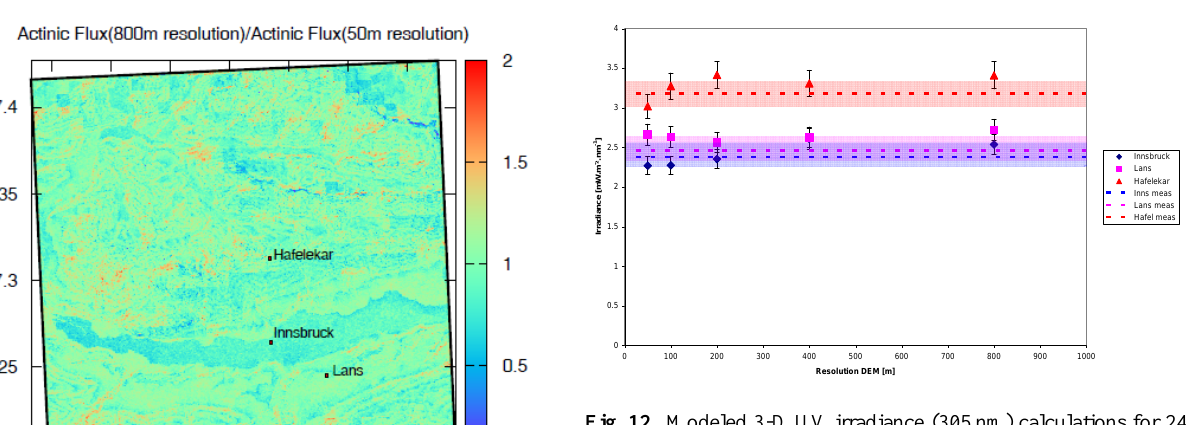
Figure 12: Modeled 3-D UV irradiance (305 nm) calculations for 24 th February, 08:20 UTC as a function of DEM resolution. Dotted lines show the measurements (interpolation of measurements before and after 08:20 UTC) which correspond to the locations and the time of calculation. Solar zenith angle is 70.0 degree. The shapes show the model results (diamond = Innsbruck, square = Lans, triangle = Hafelekar) The error bars show the accuracy of the model simulations (±5%). The coloured areas around the lines of measurements indicate the measurement uncertainty (=±5%).